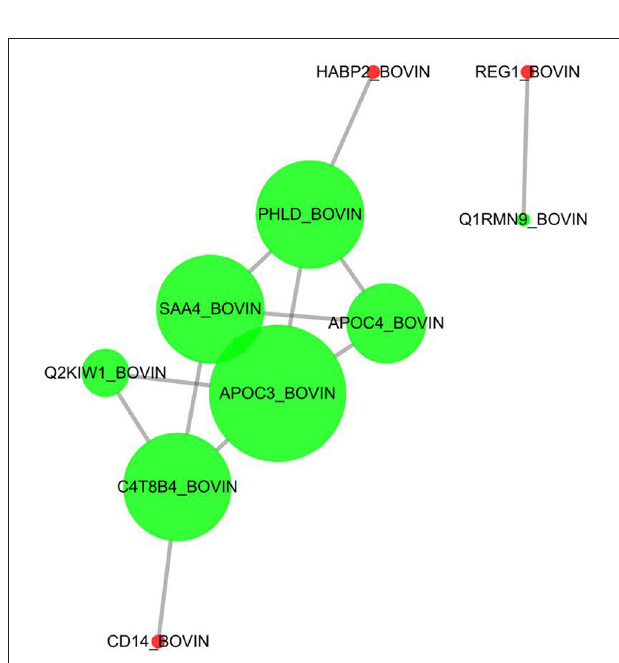
FIGURE 7 | Protein–protein directive interaction network. Ten among 26 DEPs were predicted to have directive protein–protein interactions. The interactions were based on “evidence” mode and of medium confidence. Nodes represent proteins, and edges represent protein–protein interactions. Degree determines the node size, and combined_score determines the edge